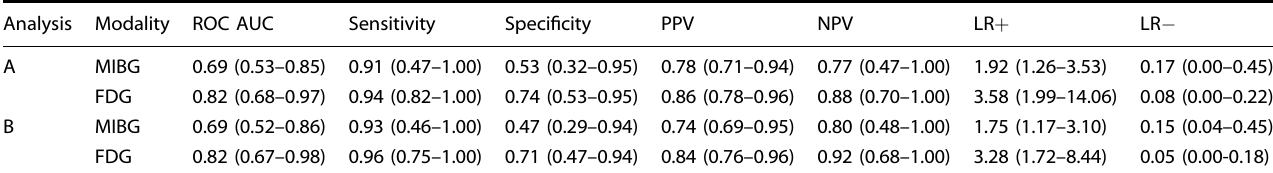
Table 2. Discriminative measures of FDG PET and MIBG scintigraphy.